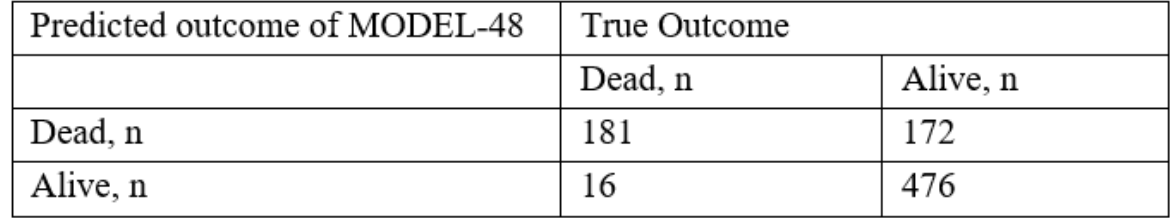
Figure 6. Binary classifier of MODEL-48. The model had an optimized F2-score threshold. This classifier had a sensitivity of 0.92, a specificity of 0.74, a positive predictive value of 0.51, and a negative predictive value of 0.97.